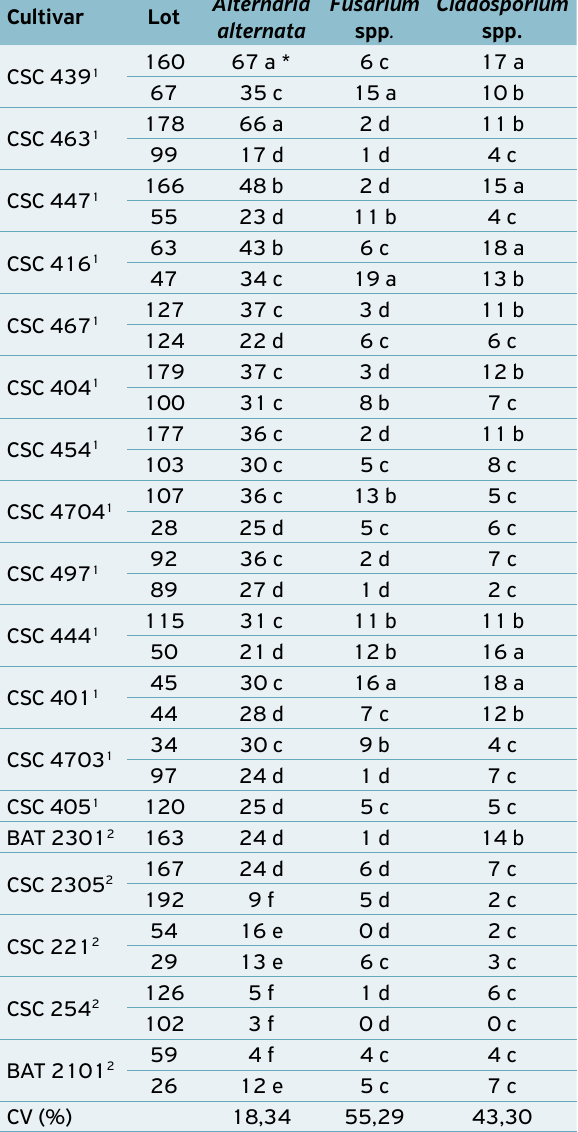
Table 1. Incidence (%) of fungi in tobacco seed batches from the 2012/2013 crop, produced by the enterprise Souza Cruz S/A. Alternaria Fusarium Cladosporium Cultivar Lot alternata spp .